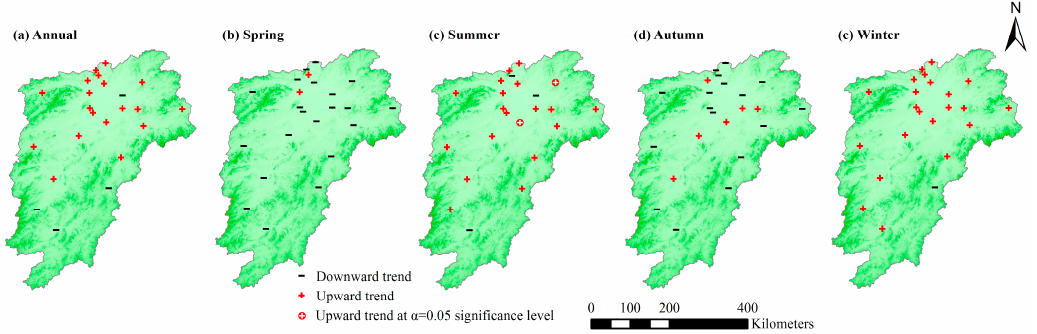
Figure 7. Spatial variation trends of the annual and seasonal SPEI values in the Poyang Lake Basin. ( a ) Annual; ( b ) Spring; ( c ) Summer; ( d ) Autumn; ( e ) Winter.